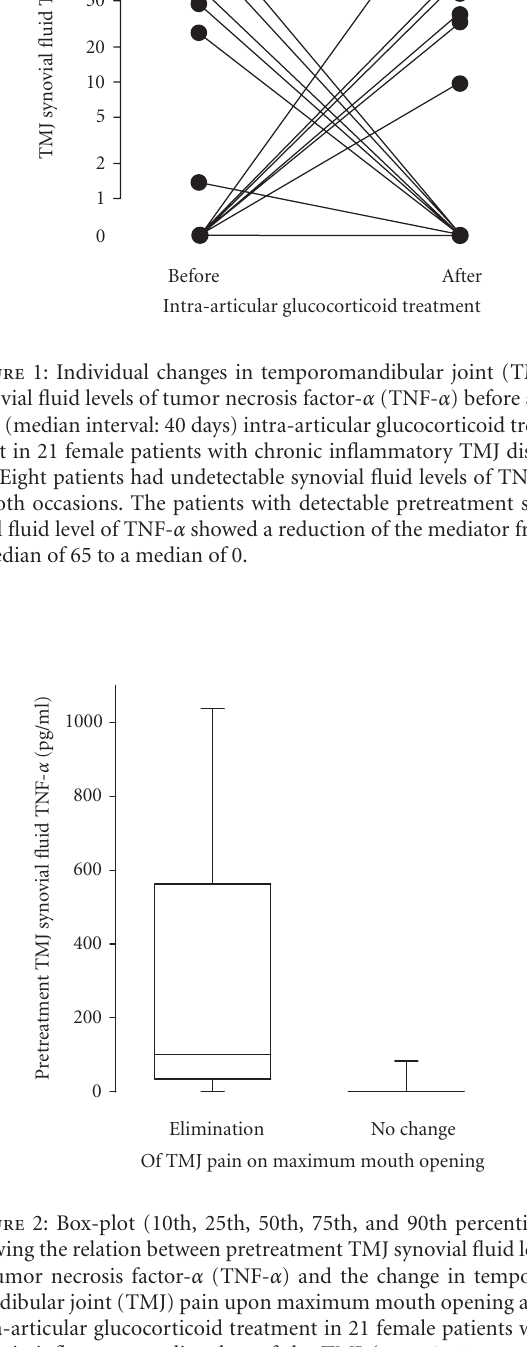
Figure 4: Box-plot (10th, 25th, 50th, 75th, and 90th percentiles) showing the pretreatment relation between temporomandibular joint (TMJ) synovial fluid level of tumor necrosis factor- α (TNF- α ) and TMJ resting pain intensity in 20 female patients with chronic inflammatory TMJ disorders ( r s = 0 . 59, n = 20, P = . 006). Four- teen patients had undetectable synovial fluid TNF- α levels, whereas seven had detectable